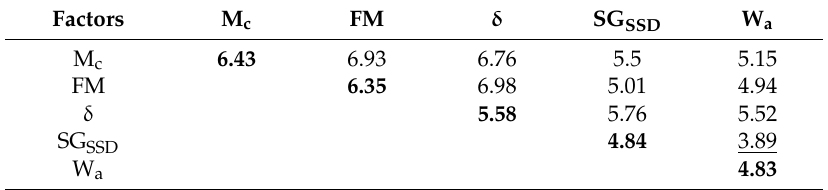
Table 8. The errors of networks for elastic modulus with different input variables—Stage b (%).